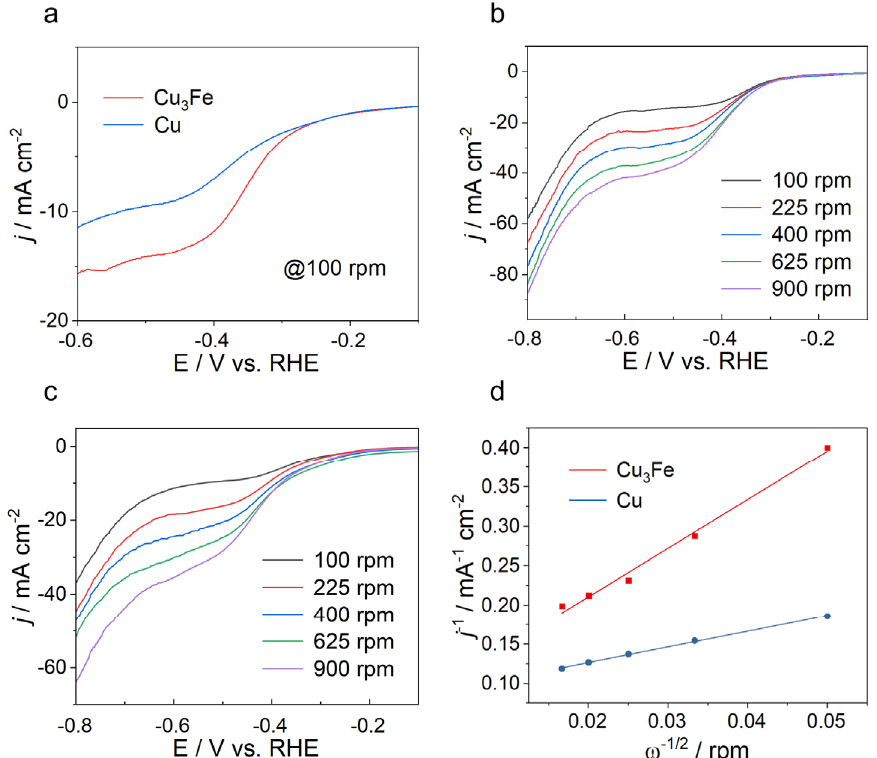
Figure 3. Electrocatalytic behavior of the CuFe catalyst towards nitrate reduction in 0.1 M Na 2 SO 4 electrolyte with 0.01 M NaNO 3 . ( a ) LSV curves of nitrate reduction on the Cu 3 Fe and plain Cu-modified RDEs at 100 rpm without the ohmic potential drop compensation. ( b ) LSV curves of nitrate reduction on the Cu 3 Fe-modified RDE at different rotation rates. ( c ) LSV curves of nitrate reduction on Cu-modified RDE at different rotation rates. ( d ) K-L plots of nitrate reduction on CuFe and Cu-modified RDEs at − 0.7 V vs. RHE.